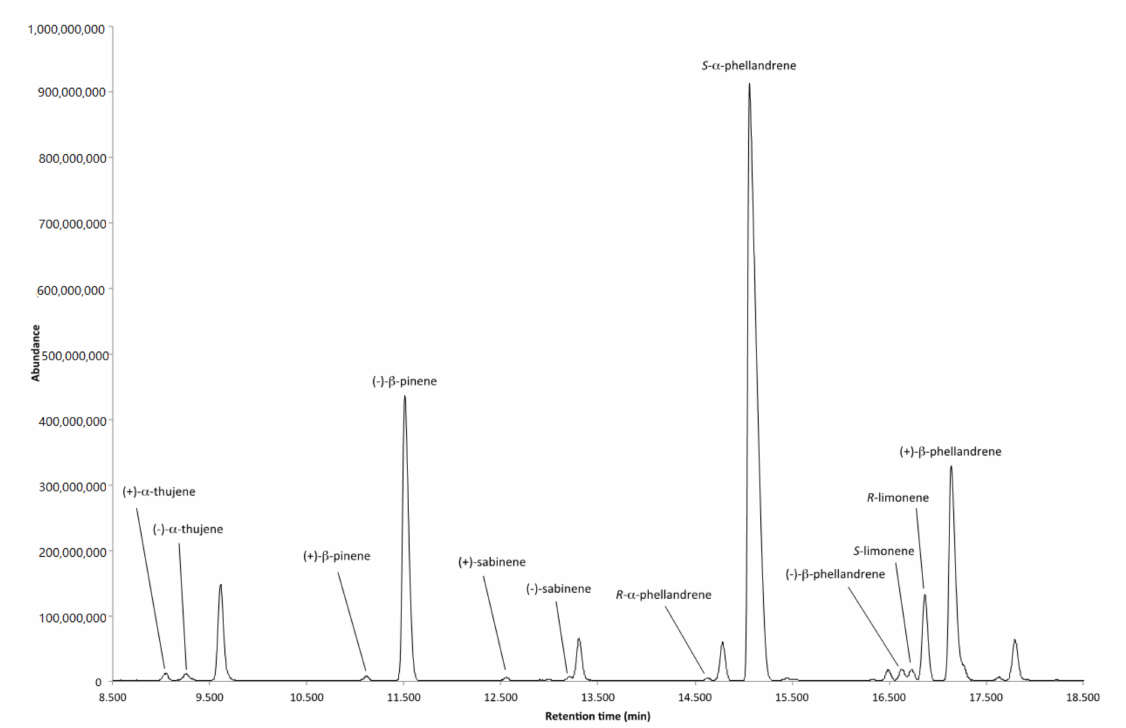
Figure 2. Chromatogram of enantiomers separated by enantioselective GC.